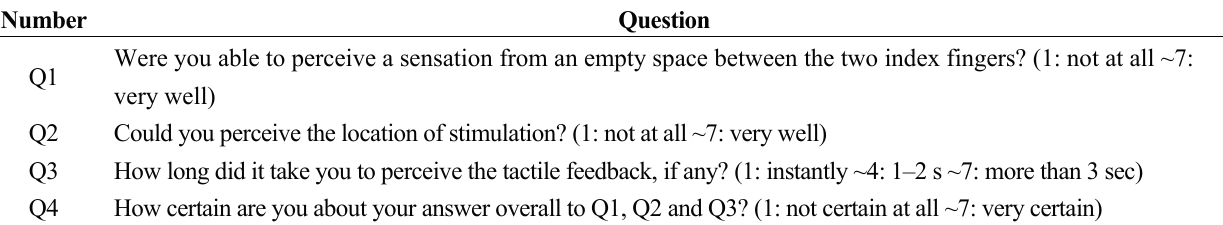
Table 1. Four questions regarding the subjective feeling of the tactile sensation responded in a 7-point Likert